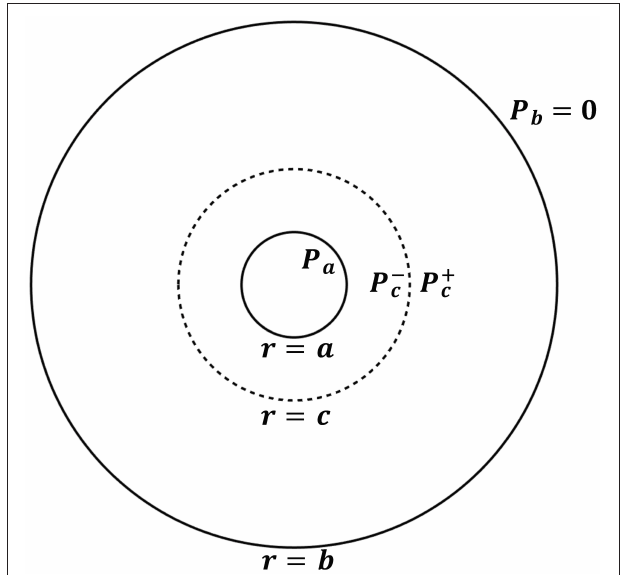
FIGURE 2 | Sketch of a classical cavity expansion problem with constant stress P a applied on the cavity. The exterior boundary ( r